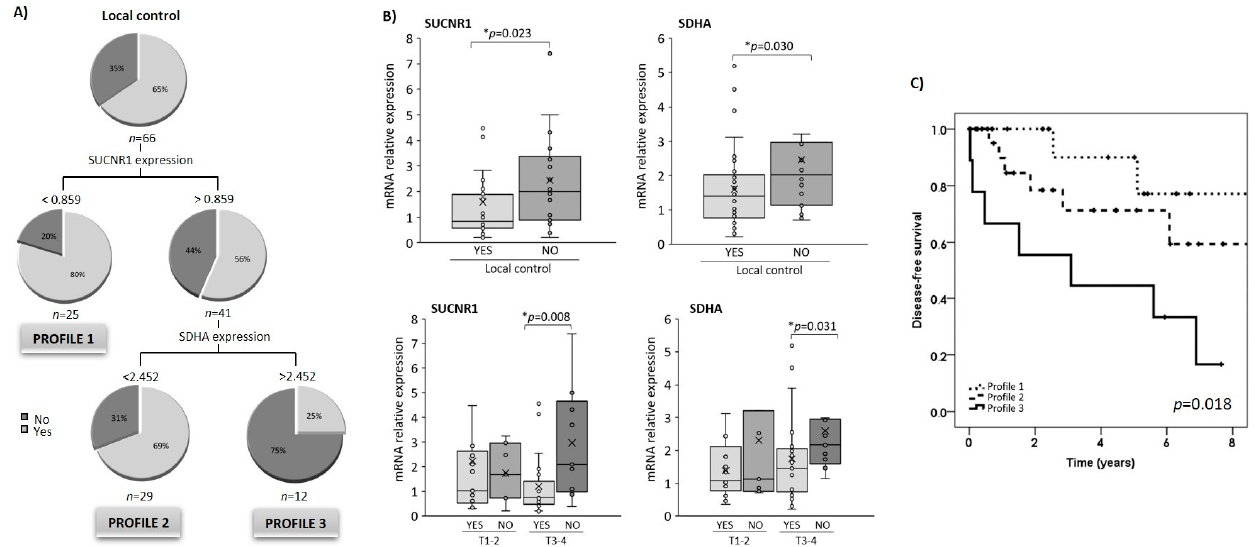
Figure 4. SUCNR1 and SDHA expression is associated with the locoregional control of the HNSCC disease. ( A ) Classification and regression tree for disease-free survival rates based on the tumoral expression of SUCNR1 and SDHA. Variables included were the tumoral expression of HIF-1 α , SDHA, SDHB, OGDH and SUCNR1, the primary location, the stage, T- and N-categories, tumor differentiation degree, the treatment and body mass index categories. Pie charts represent the proportion of patients who met the locoregional disease-free survival (light grey; yes) or not (dark grey; no) at each node of the tree; “Yes” includes patients that are free of disease at the last follow-up; and “No” includes patients that are not free of disease at the last follow-up. ( B ) SUCNR1 and SDHA expression according to the locoregional control achieved (upper panel). SUCNR1 and SDHA expression in T1-2 and T3-4 according to the locoregional control achieved (lower panel). Results are expressed as median (IQR). Differences between groups were calculated using the Mann–Whitney U test for independent samples. *, Differences were considered statistically significant at p < 0.05. ( C ) Kaplan–Meier survival analysis showing locoregional recurrence-free survival according to the categorized levels of SUCNR1 and SDHA expression in tumors. Profile 1: SUCNR1 expression <0.859; Profile 2: high SUCNR1 expression (>0.859) and low SDHA expression (<2.452); Profile 3: high SUCNR1 and SDHA expression.